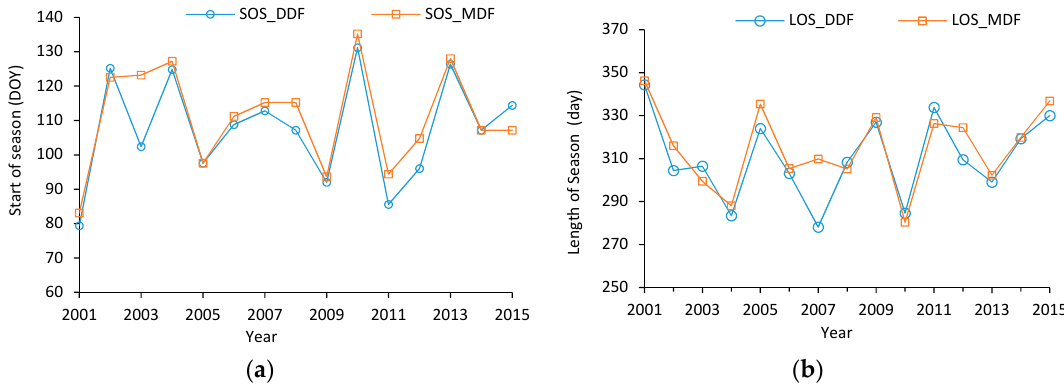
Figure 10 . Inter-annual variations of tropical deciduous forest phenology metrics in different forest types period 2000 – 2015; ( a ) Start of growing season (SOS); ( b ) length of growing season (LOS).